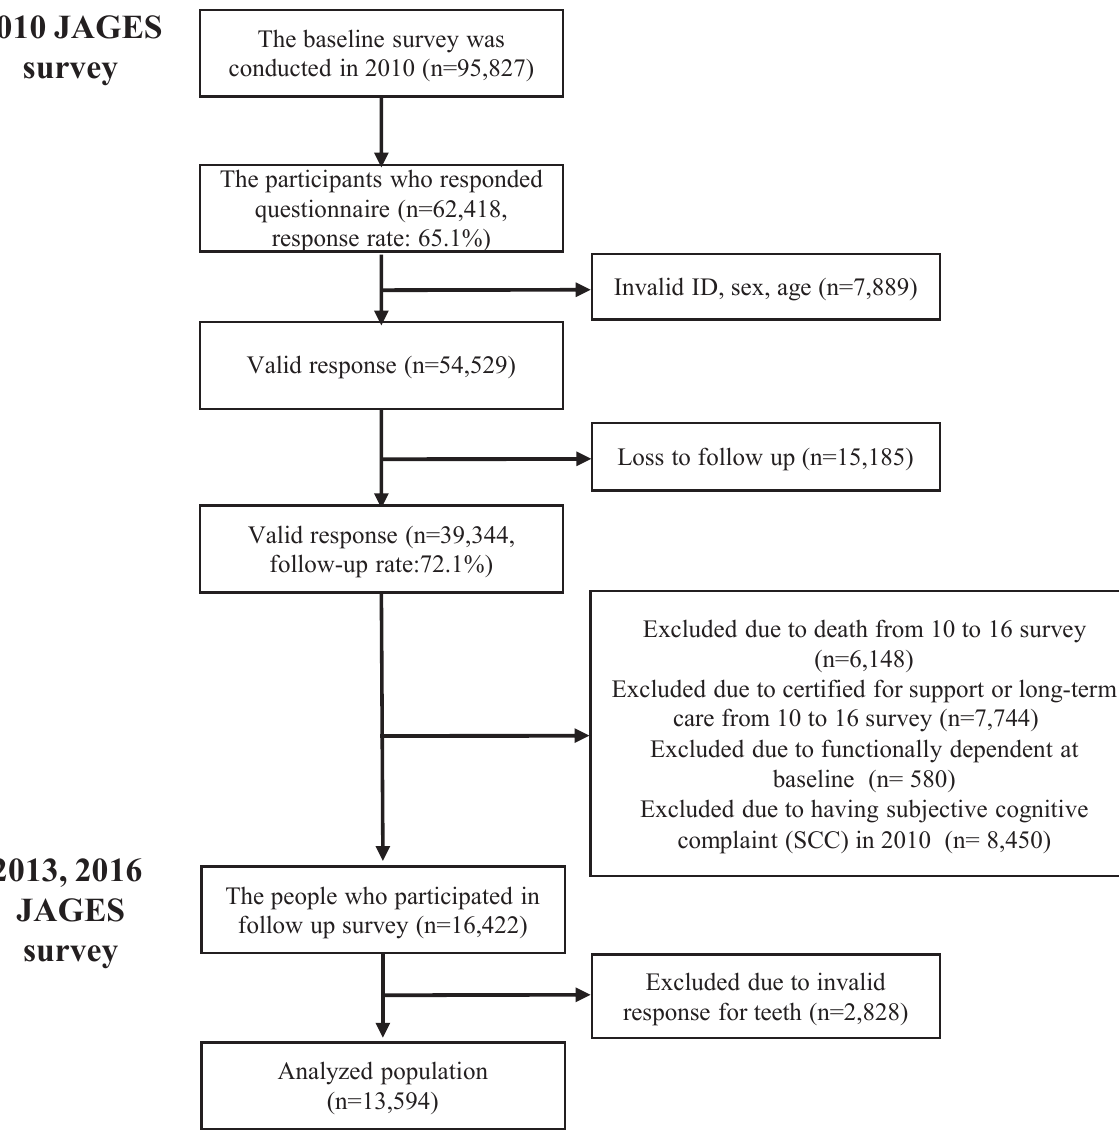
Figure 1. The fl owchart of the participants for the